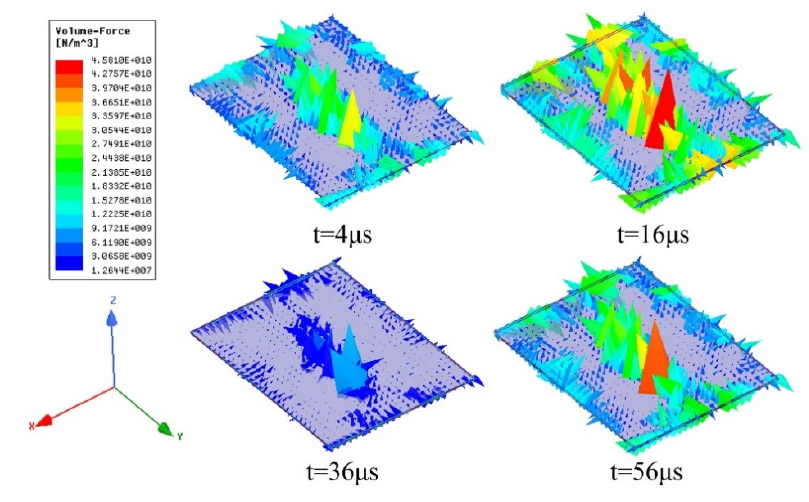
Figure 8. Distribution of electromagnetic force of Al sheet.